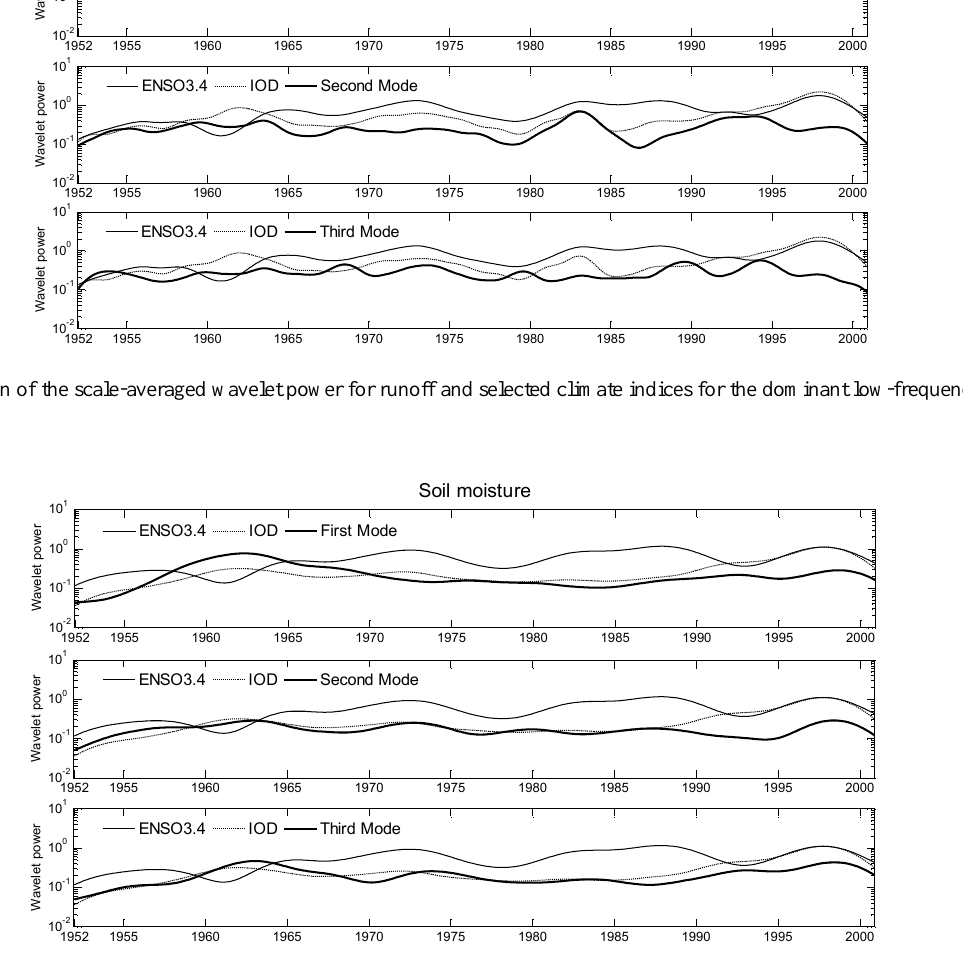
Fig. 11. Comparison of the scale-averaged wavelet power for soil moisture and selected climate indices for the dominant low-frequency variability band 1.92–5.21 yr.